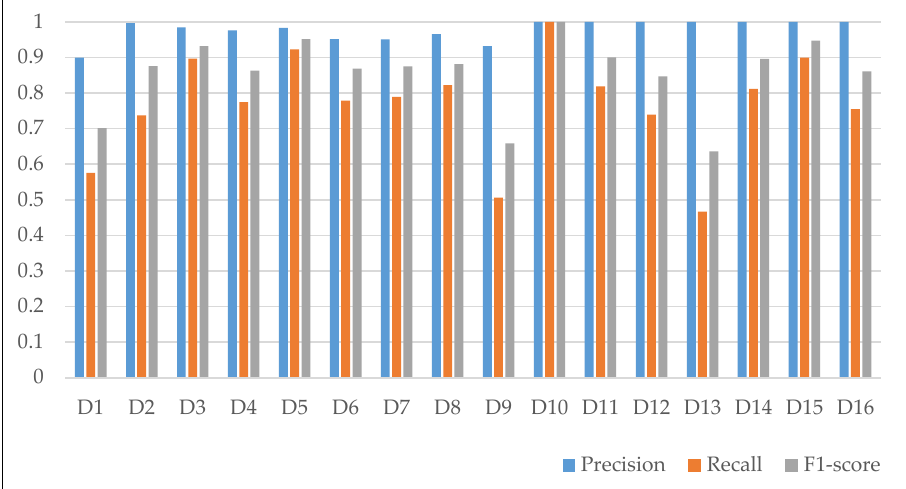
Figure 5. Precision, Recall, and F1-score for the negative samples of 16 datasets.